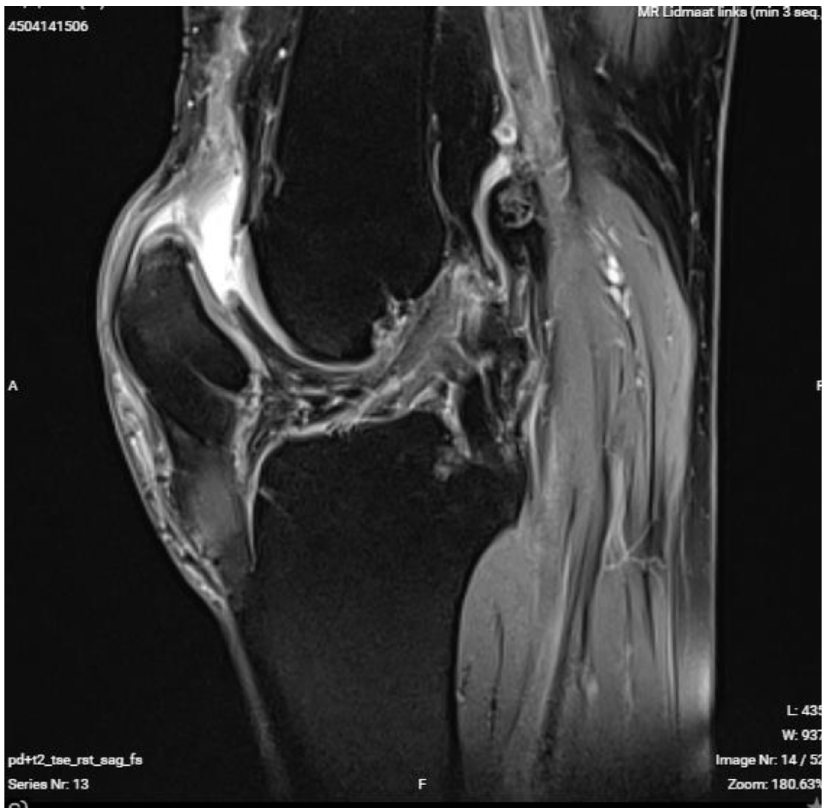
Figure 1. MRI showing the quadriceps